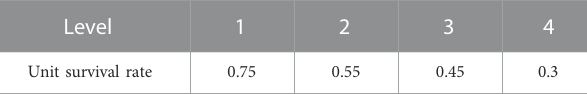
TABLE 1 DPV survival rate under different levels of typhoon.